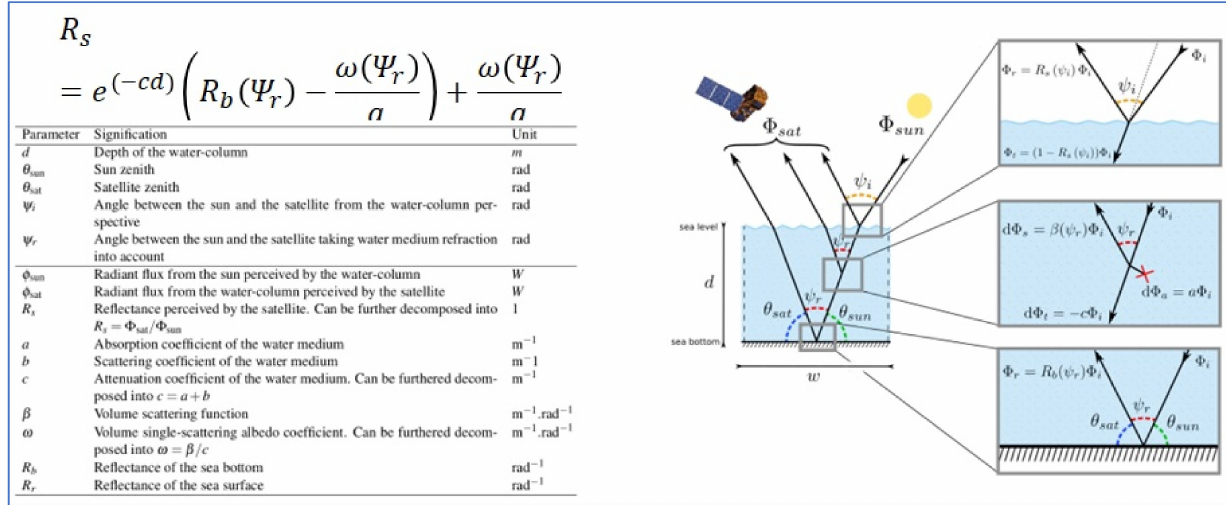
Figure 7. Traditional Lee et al. RTE.